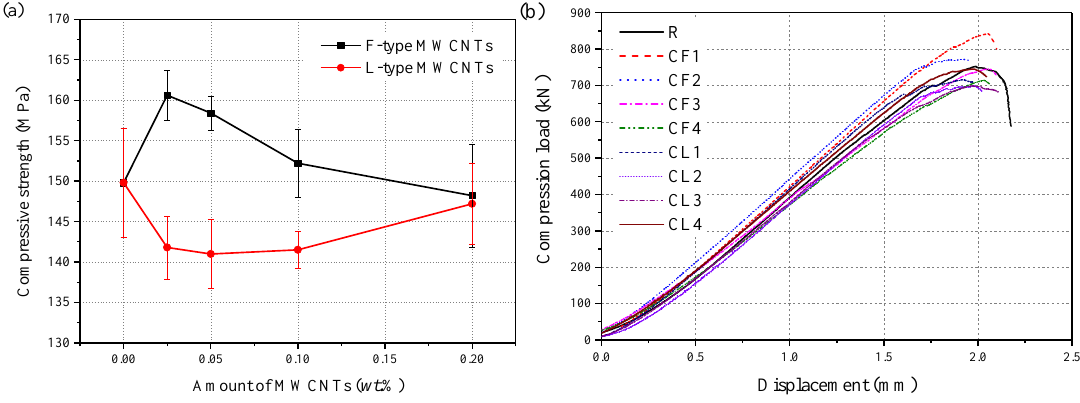
Figure 3. Compression test result ( a ) and typical compressive load-displacement curve ( b ).